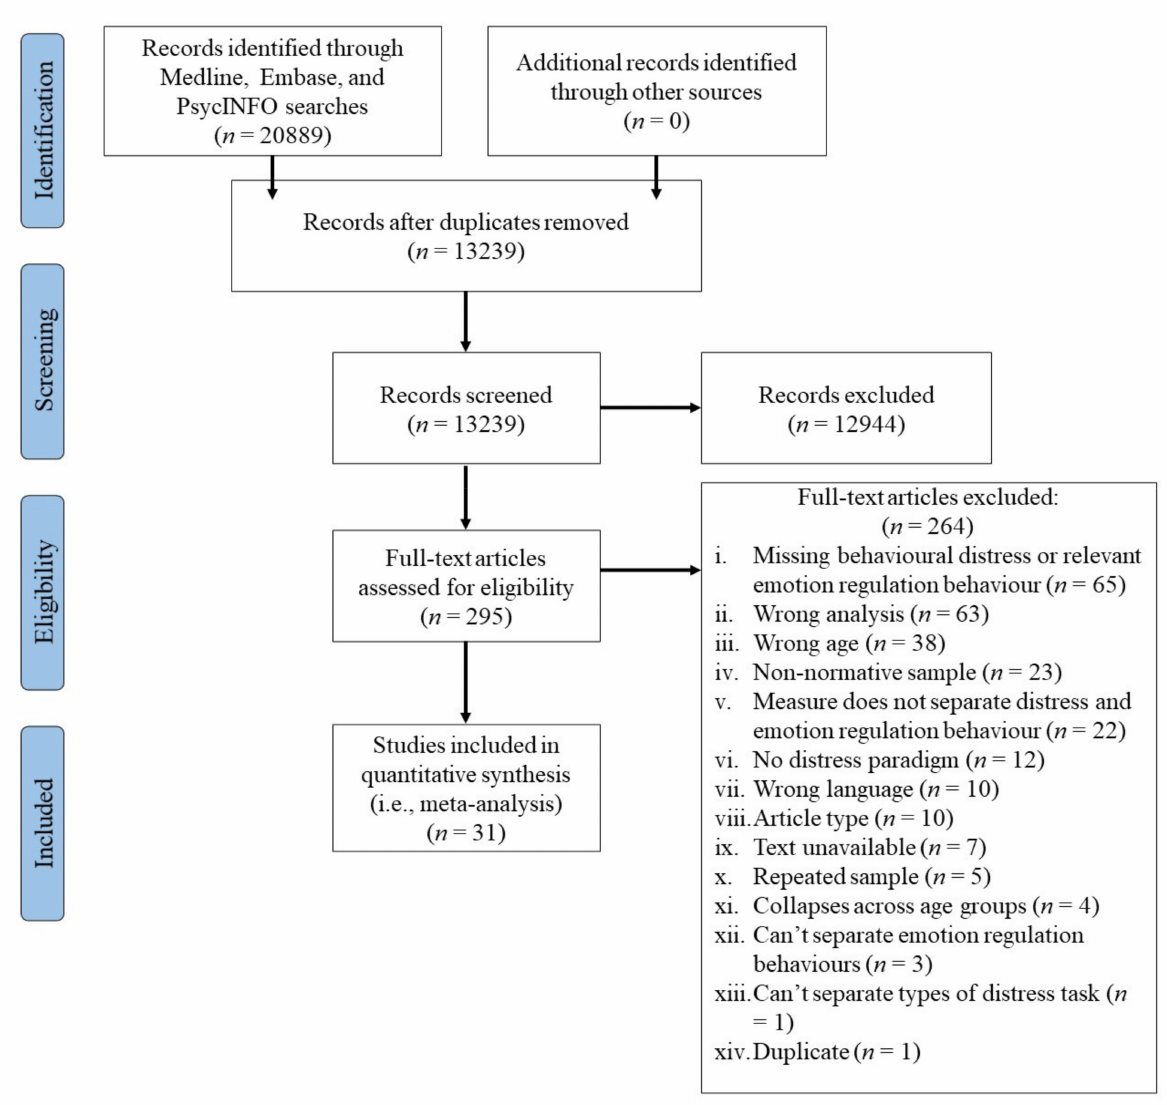
Figure 1. PRISMA flow